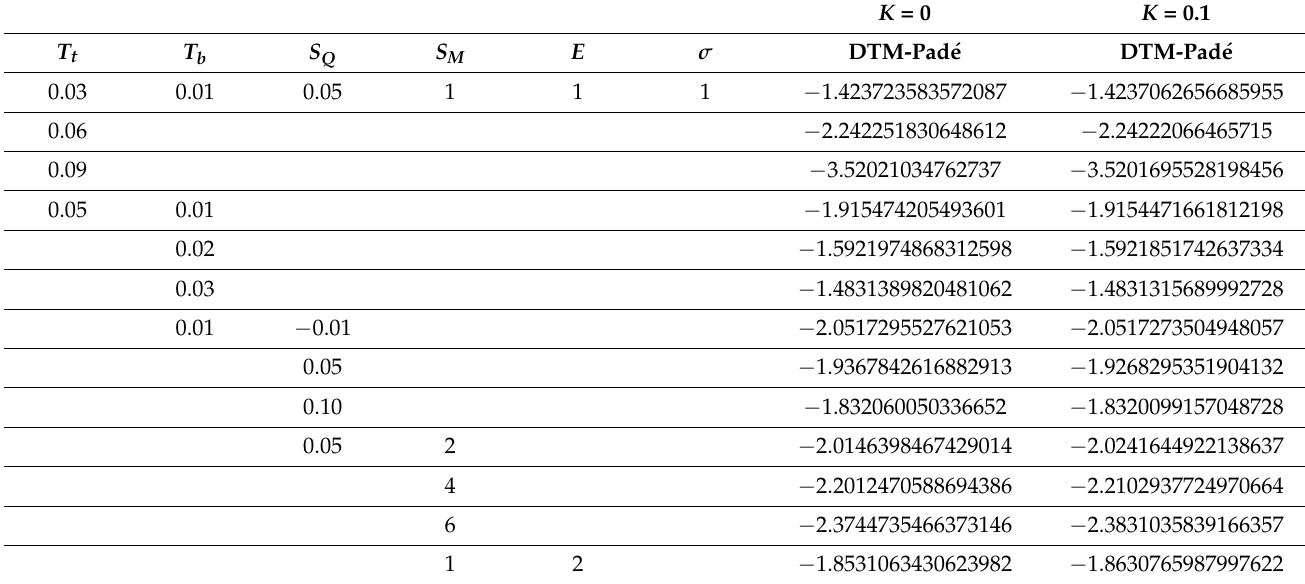
Table 3. Analysis of Sherwood number φ (cid:48) ( 0 ) for various values T t , T b , S Q , S M , E , σ by DTM-Pad é [ 5 × 5 ]